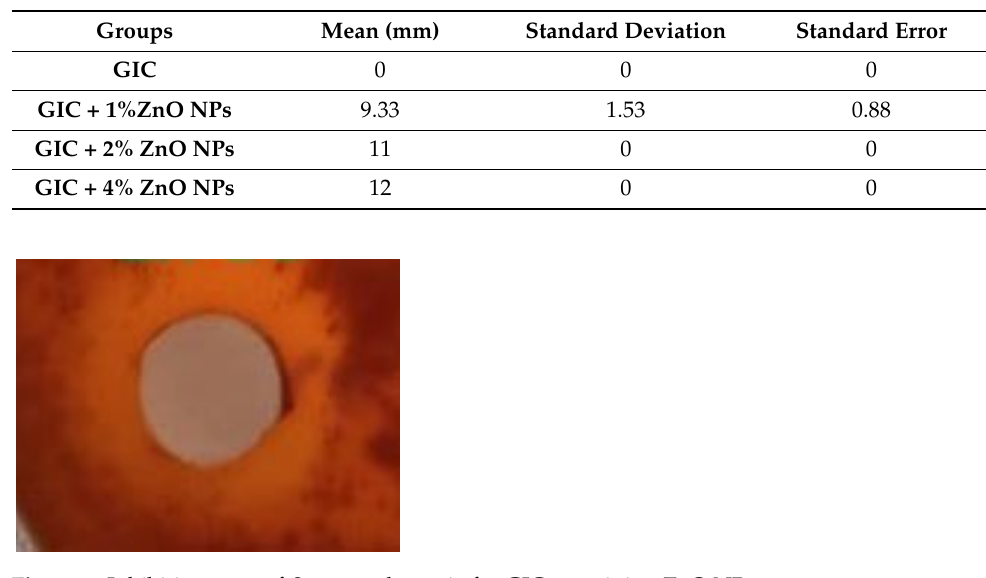
Table 3. Diameter of the inhibition zone of S. mutans bacteria for GIC in in different weight percentages of ZnO NPs.